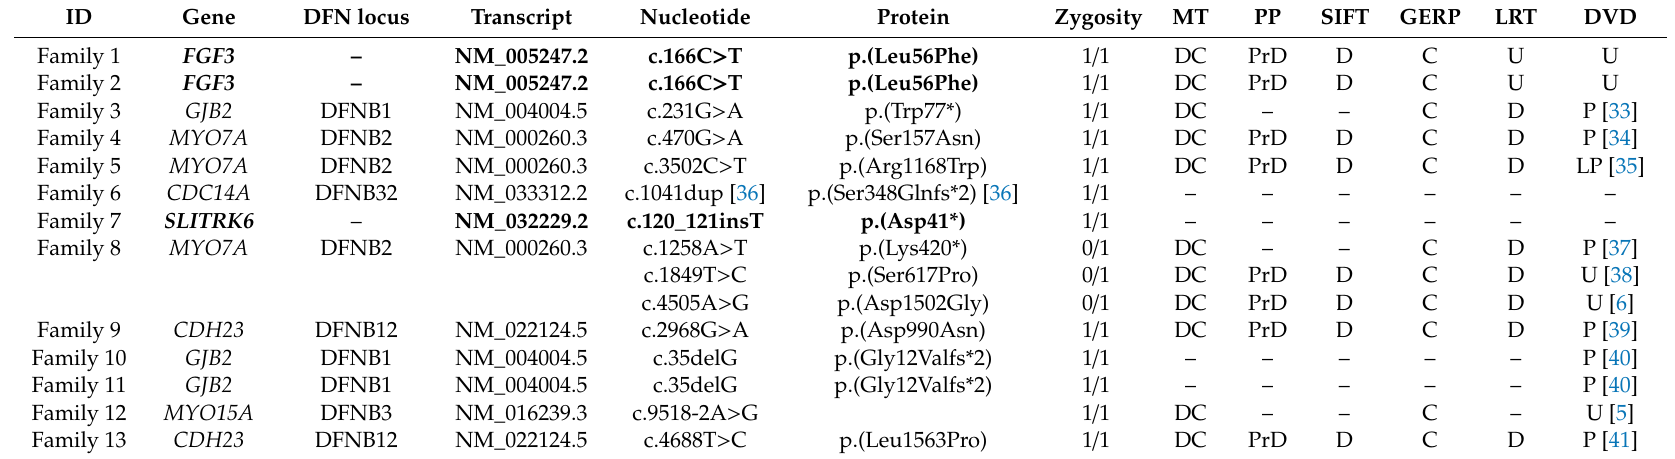
Table 1. Likely causal variants identified in Pakistani families with hearing loss